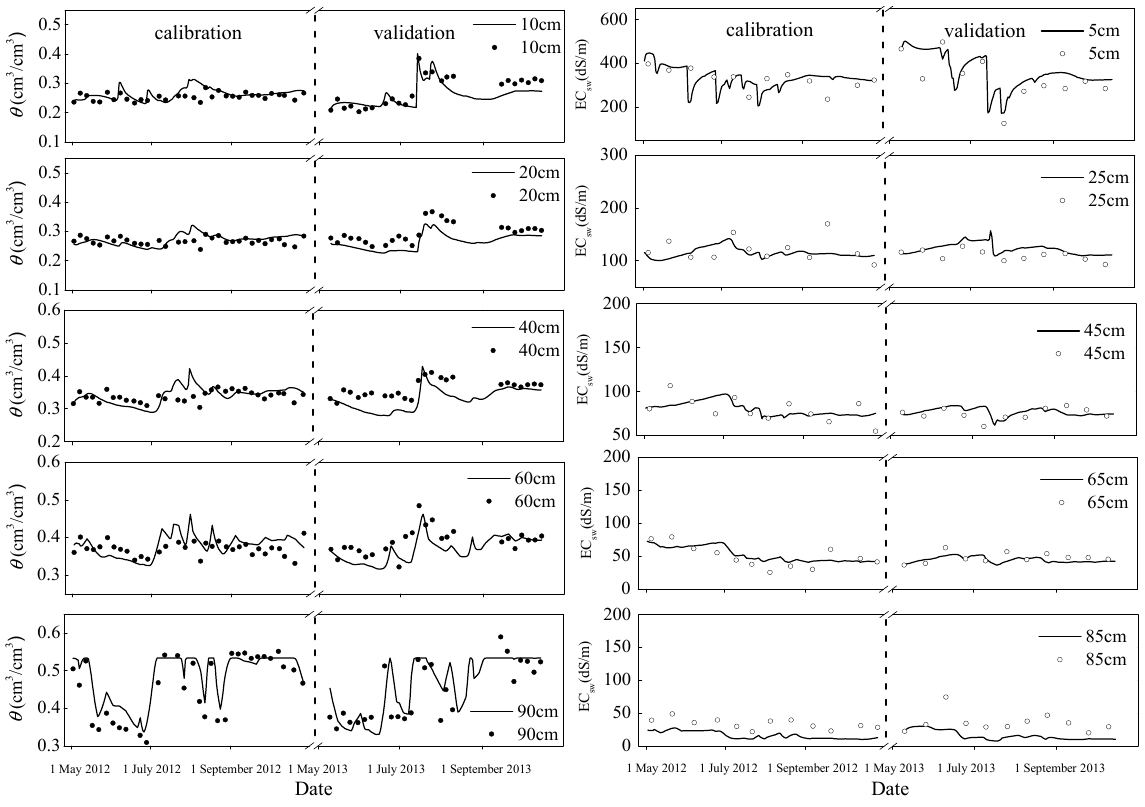
Figure 3. Measured and simulated soil water and EC sw in both calibration and validation period during the growing season of Chinese tamarisk